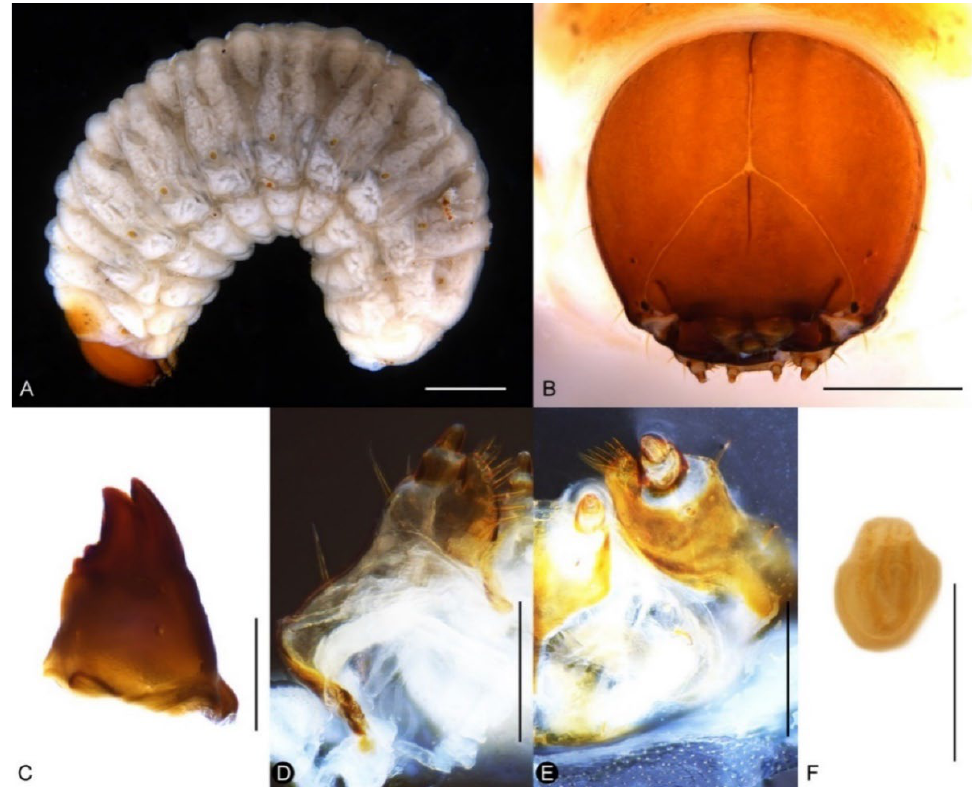
Figure 12. Diagnostic characters of final-instar larva of Miltotranes prosternalis : ( A ) habitus, lateral view; ( B ) head, frontal view; ( C ) right mandible, dorsal view; ( D ) maxilla, dorsal view; ( E ) maxilla and labium, ventral view; ( F ) abdominal spiracle II. Scale bars: ( A ) 1.0 mm; ( B ) 0.5 mm; ( D – F ) 0.2 mm.